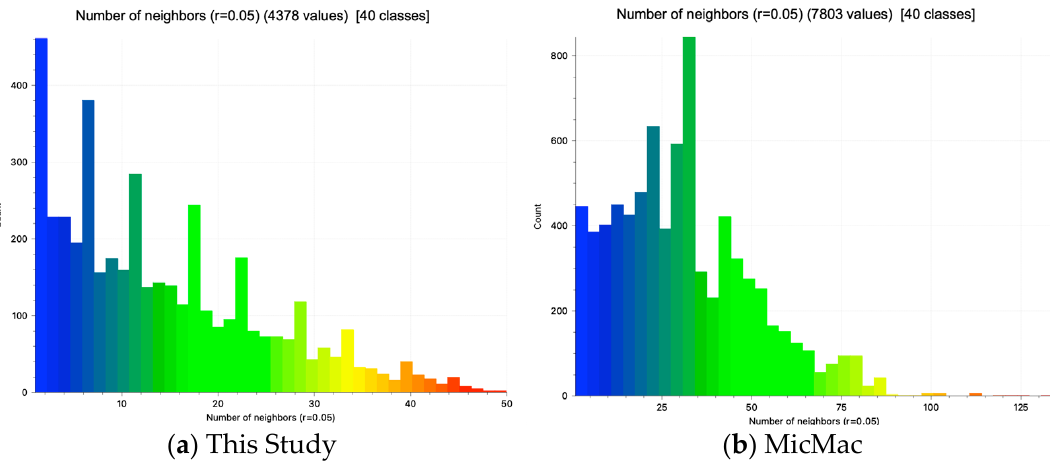
Figure 14. Histogram of the density evaluation of a small shift on the reconstruction in CloudCompare.